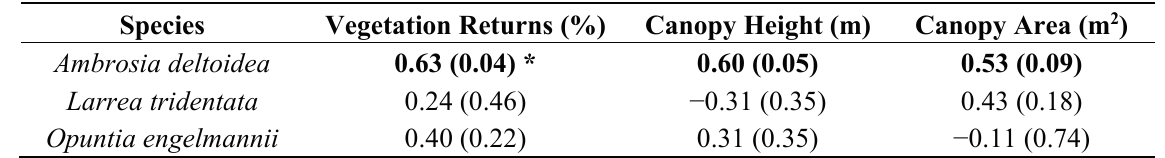
Table 5. Pearson correlation coefficients (p) for times series of LiDAR-derived variables and Normalized Difference Vegetation Index (NDVI) derived from Moderate Resolution Imaging Spectroradiometer (MODIS) 16-day composites (1-composite